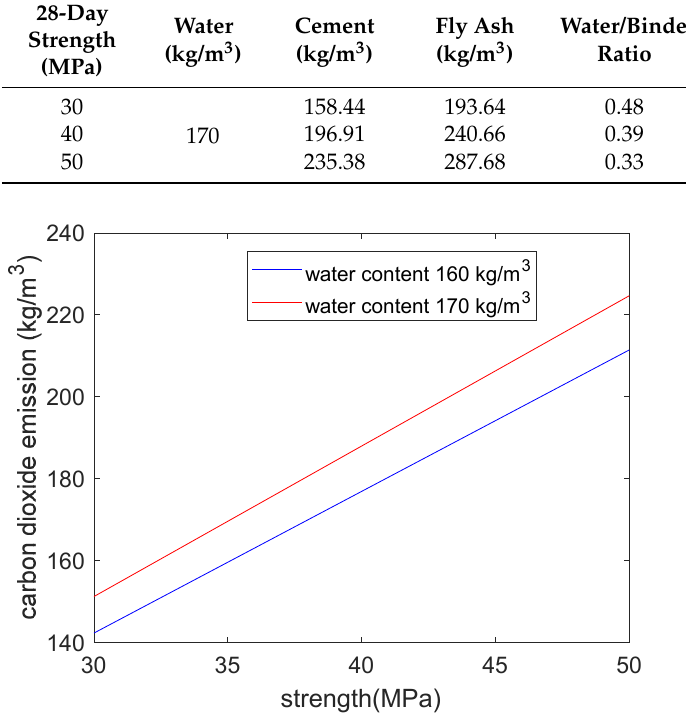
Figure 11. Effect of water content on CO 2 emissions.